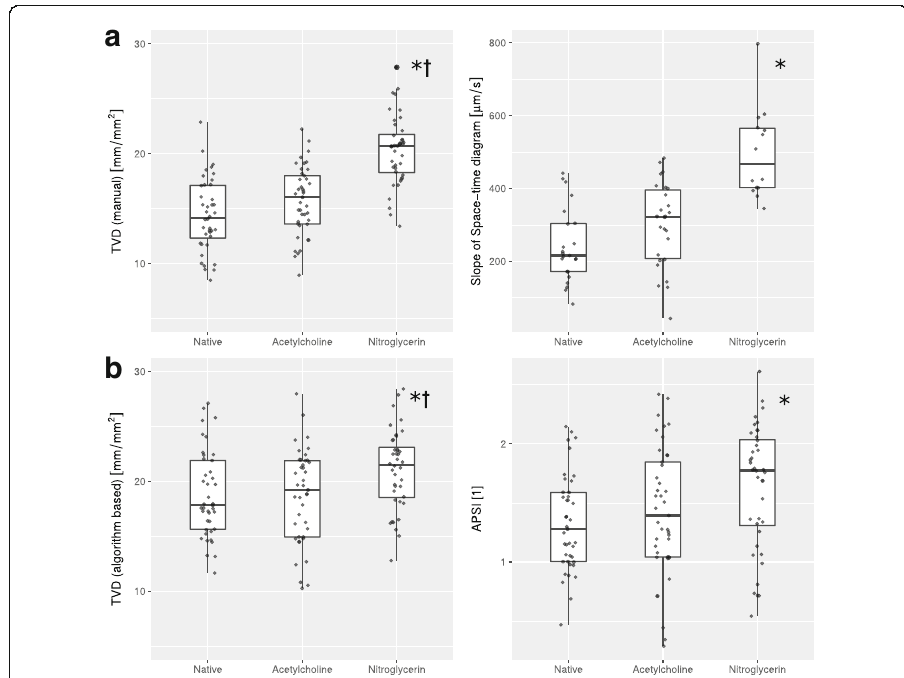
Fig. 2 Properties of the sublingual microcirculation before (native) and after the topical sublingual application of acetylcholine and nitroglycerin. a Total vessel density (TVD) and space-time diagram-based flow velocity of the venules as determined using manual video analysis. ANOVA p <0.0001 for TVD and p <0.01 for space-time diagram-based flow velocity; asterisk denotes values differing from native examination in pairwise analysis ( p <0.05), dagger denotes values differing to acetylcholine stimulation in pairwise analysis ( p <0.05). b Total vessel density and average perfused speed index (APSI) as determined using algorithm-based video analysis. ANOVA p <0.01 for TVD and p =0.02 for APSI; asterisk denotes values differing from native examination in pairwise analysis ( p <0.05), dagger denotes values differing to acetylcholine stimulation in pairwise analysis ( p <0.05). Boxplots represent median, interquartile range, and range. Horizontal scattering is applied to the individual data